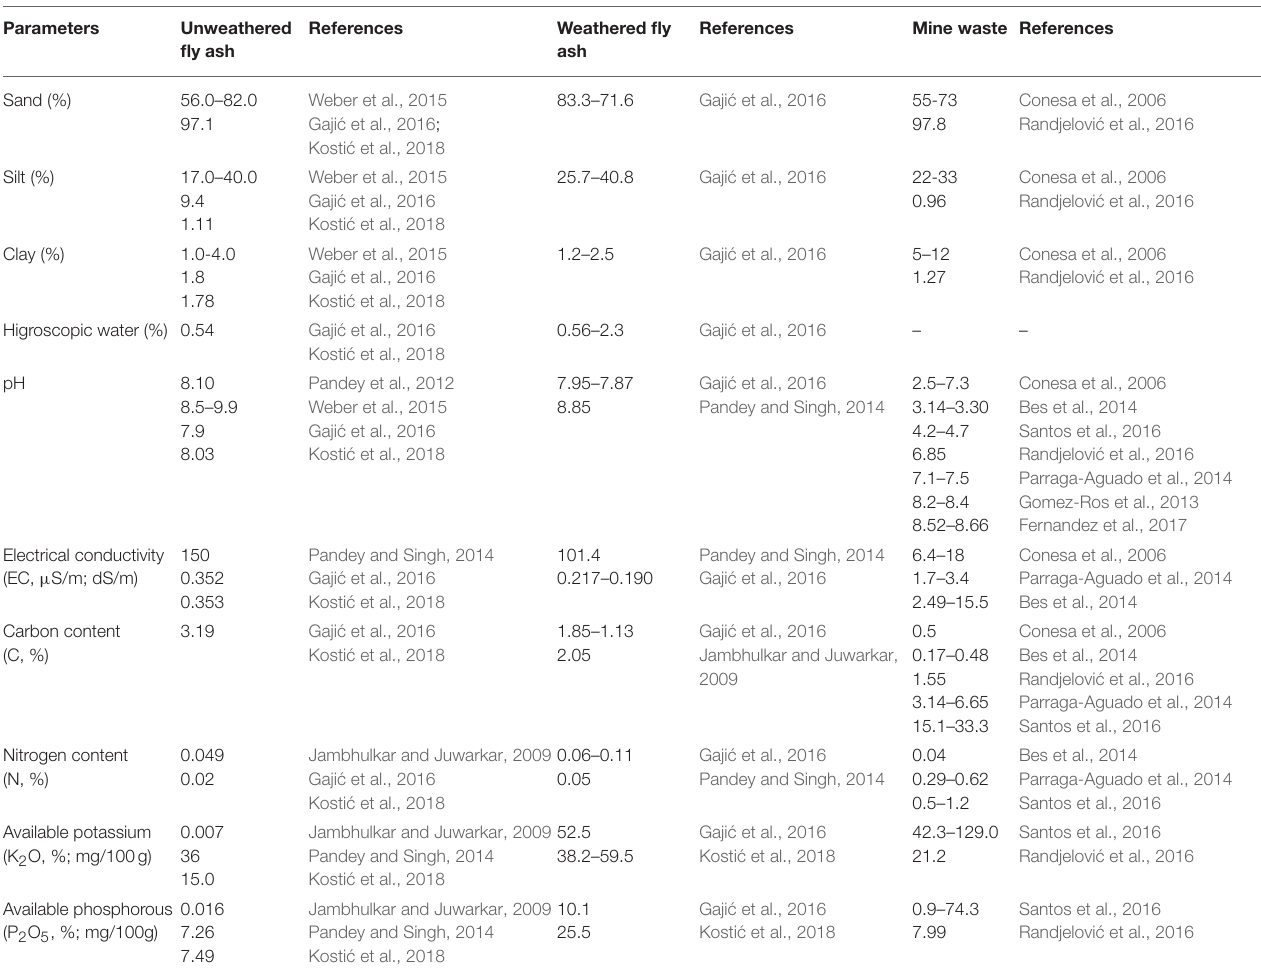
TABLE 1 | Physico-chemical characteristics of fly ash and mine waste.